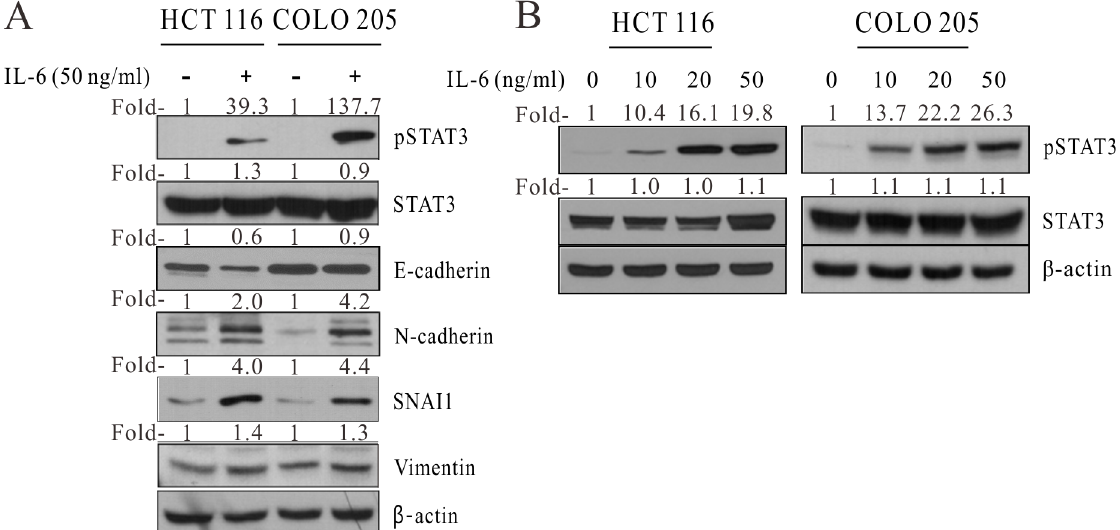
Fig 4. IL-6 induced EMT through STAT3 phosphorylation. (A) Western blot of HCT 116 and COLO 205 cells treated with 50 ng/mL IL-6. (B) Western blot analysis of HCT 116 and COLO 205 cells after exposure to increasing concentrations of IL-6. Fold-, fold-change; pSTAT3, phosphorylated STAT3; β -actin, beta